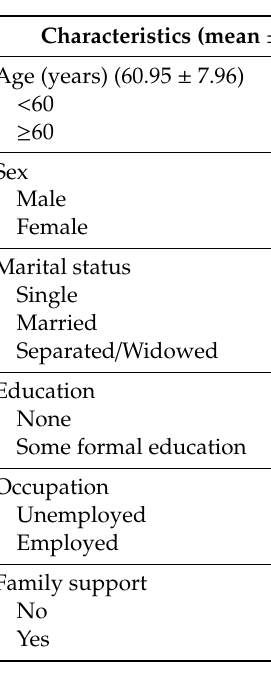
Table 1. Demographics characteristics of respondents (n =